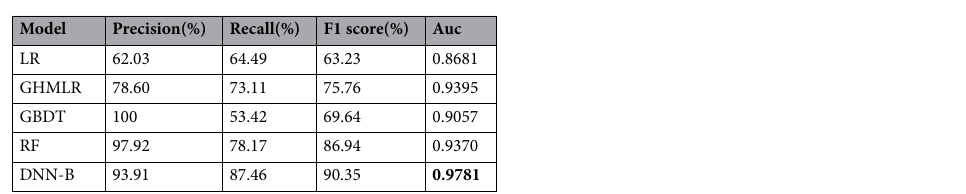
Table 4. Comparison on binary classifications of stroke occurrence prediction. Significant values are in